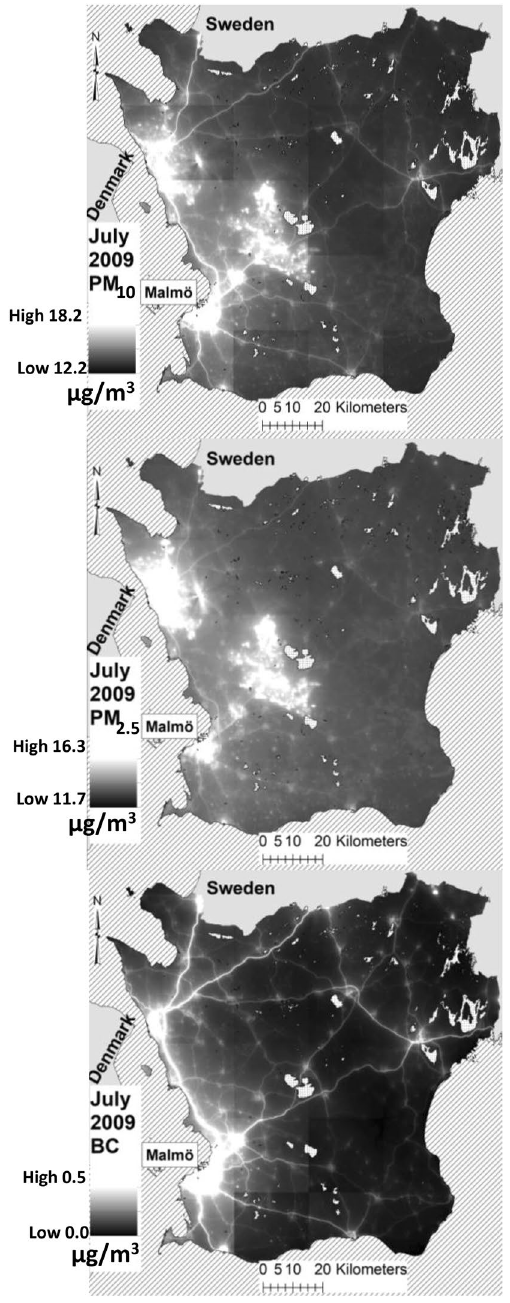
Fig. 10 Concentrations of PM July 2009 background levels added where